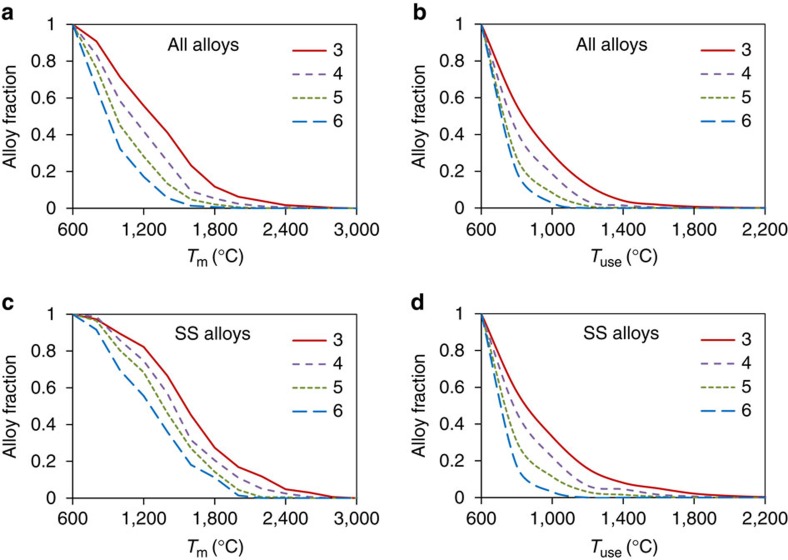
Cumulative distributions of N-component equimolar alloys by Tm and Tuse.(a) Tm, all alloys, (b) Tuse, all alloys, (c) Tm, SS alloys, (d) Tuse, SS alloys.